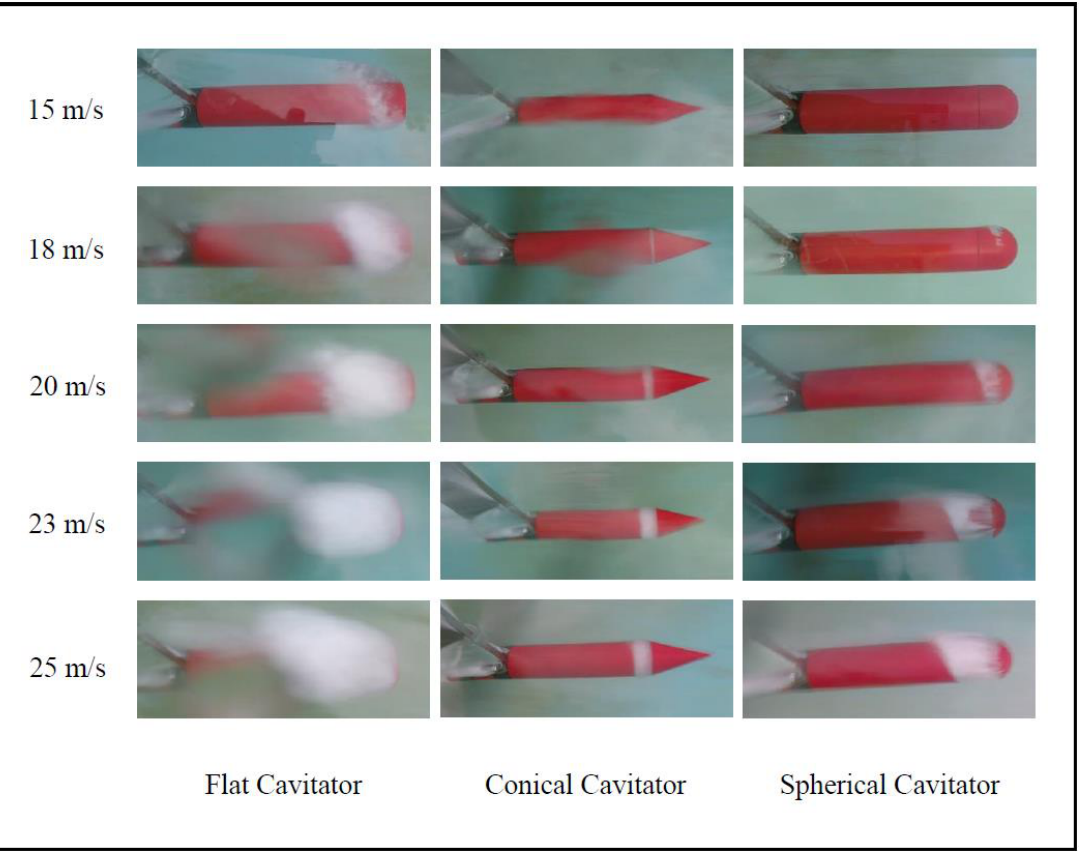
Figure 4. Bubble development for flat, conical, and spherical cavitators at different cruise speeds.